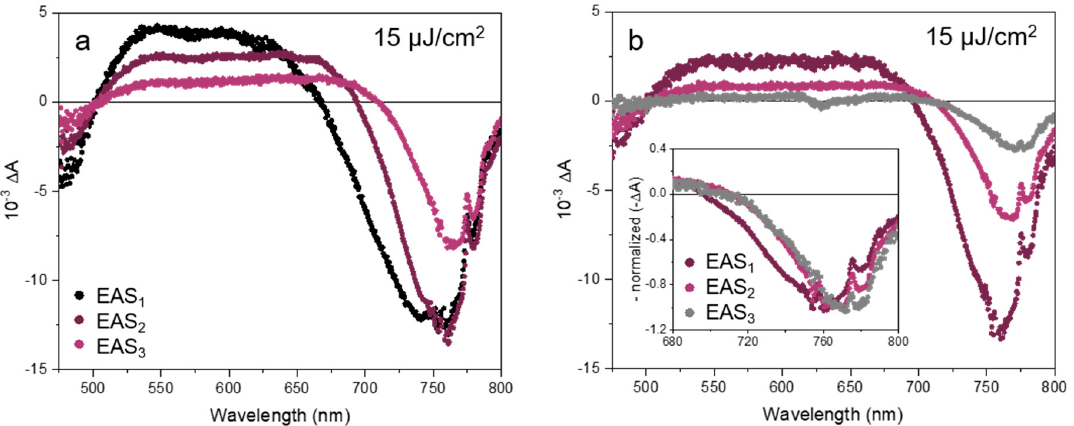
Figure A2. Evolution associated spectra of the thick FAPbI 3 NPs excited at 630 nm at 15 µ J / cm 2 , obtained with the middle ( a ) and long ( b ) time range global analysis. The inset in ( b ) show the lineshape evolution of the three components for normalized